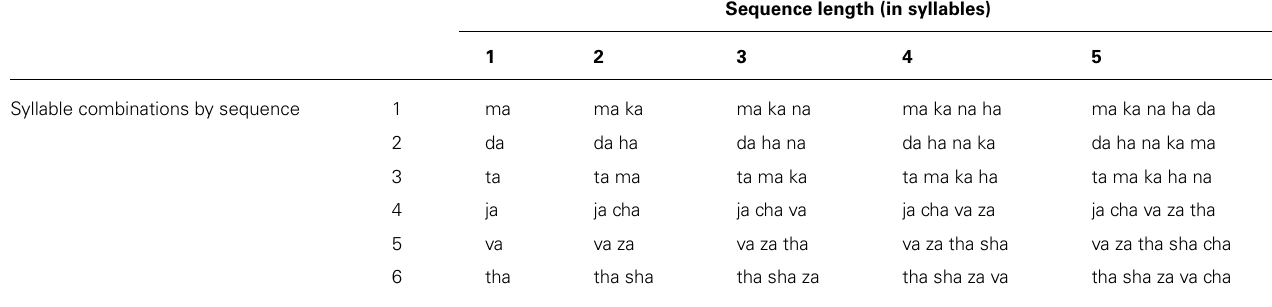
Table 3 | Syllable sequence